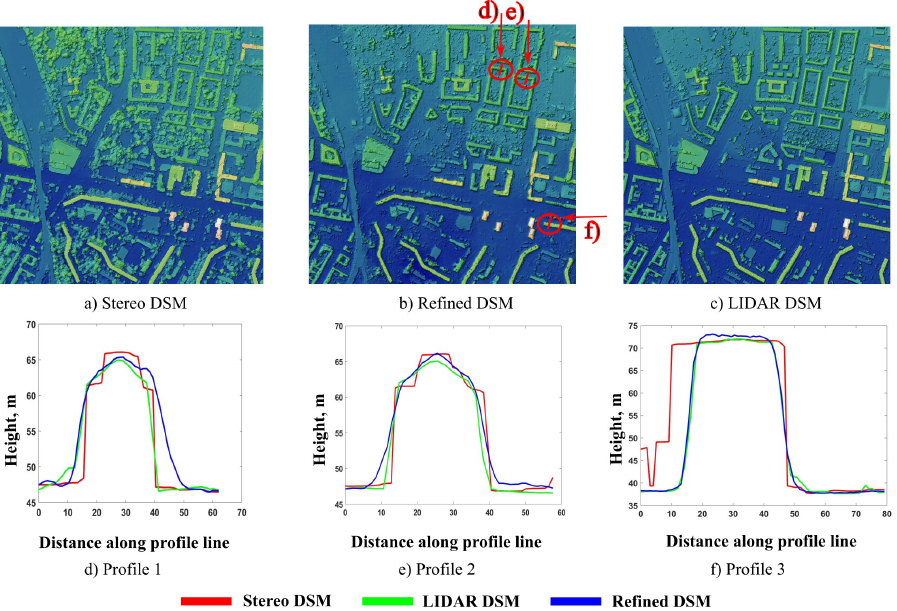
Figure 3. Examples of the generated DSM with refined 3D buildings shapes and roofs ridge lines.